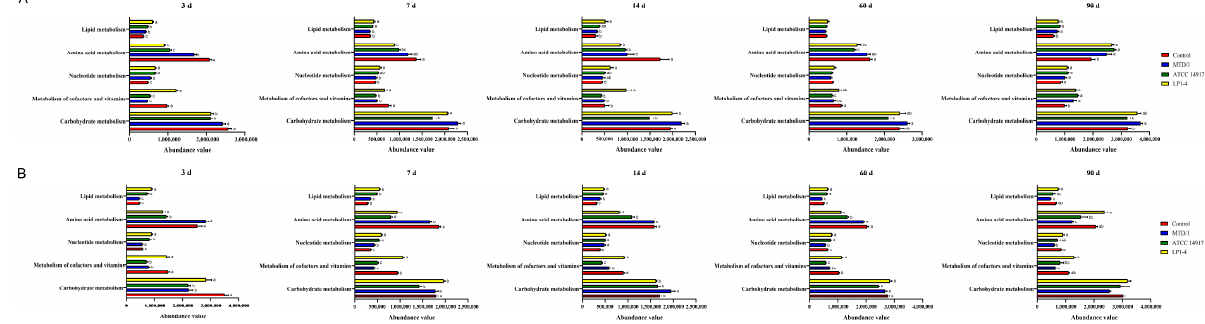
Figure 5. Dynamics of functional predictions related to antibacterial mechanisms of bacteriocins in alfalfa silage at the ( A ) moderate and ( B ) high dry matter contents, respectively. Control, distilled water; MTD/1, MTD/1 treatment; and ATCC14917, ATCC14917 treatment. Different lowercase letters indicate significant differences in treatments ( p < 0.05).